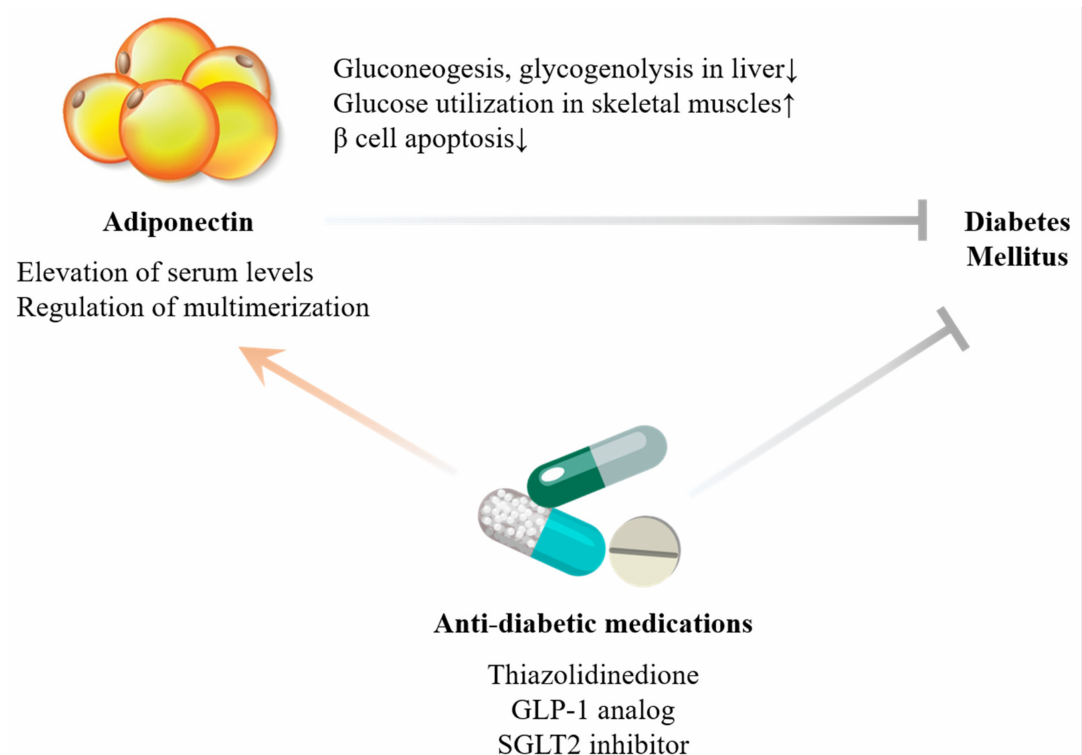
Figure 1. Anti-diabetic potential of adiponectin. Adiponectin enhances insulin sensitivity through multiorgan involvement to alleviate the progression of diabetes mellitus. Cumulative evidence has supported the favorable actions of anti-diabetic medications on adiponectin. The up arrows denote the increase, while the down arrows denote the